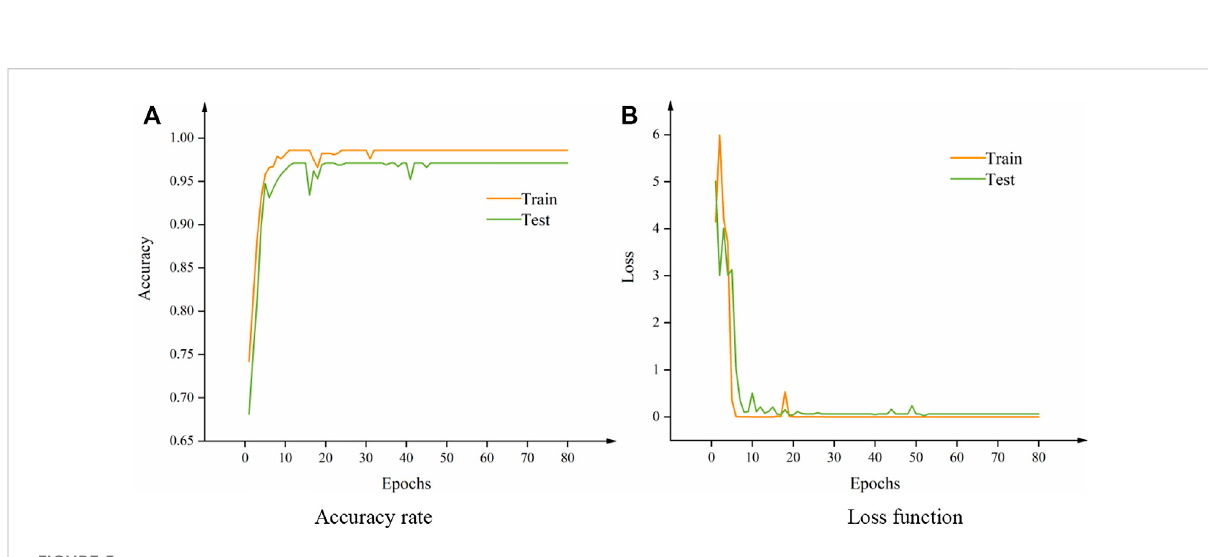
Number of iterations to convergence